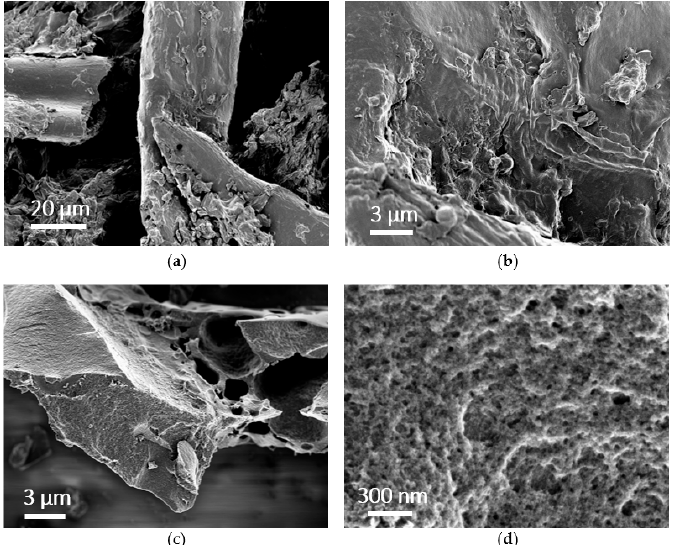
Figure 2. SEM images of untreated CSS at different magnifications ( a , b ) and AC—CSS ( c , d ) derived therefrom.